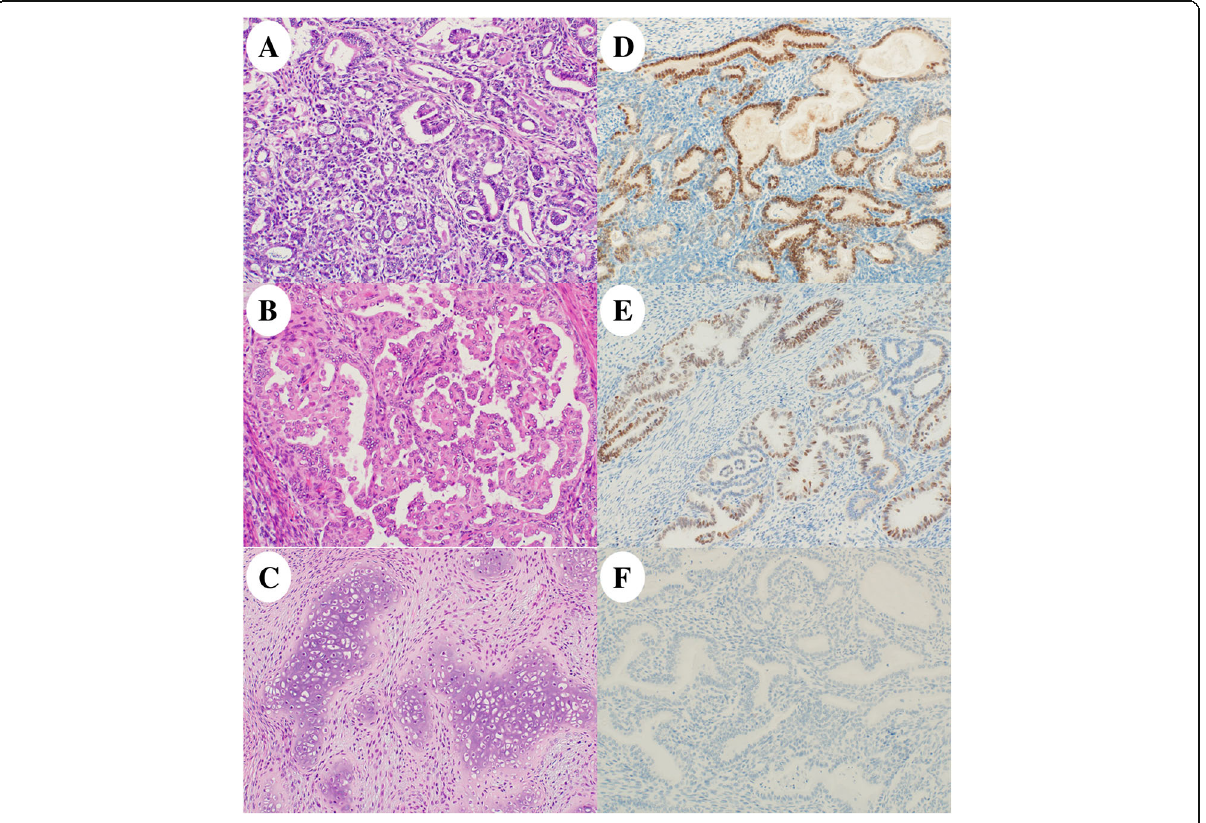
Fig. 2 Histology and immunohistochemistry of the recurred tumor. The tumor had a variety of histologic patterns including ( a , 20×) tubular and glandular, ( b , 20×) papillary, and ( c , 40×) spindled and solid with a heterologous element (cartilage without atypia). Immunohistochemical analysis showed positive staining for ( d , 2 × 0) thyroid transcription factor 1 and ( e , 20×) GATA-3; however, the tumor was negative for ( f , 20×) estrogen